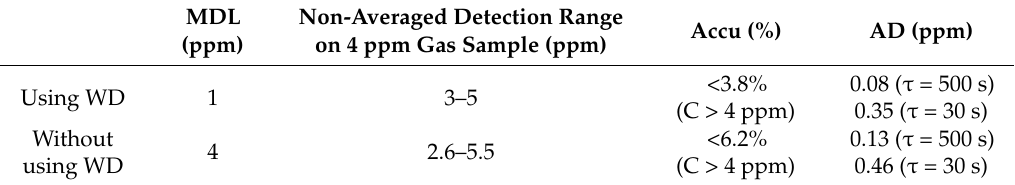
Table 1. Comparison between the sensing performances under the cases of with and without WD use. Accu: accuracy; MDL: minimum detection limit; RT: response time; AD: Allan deviation. This table was obtained from reference [40]. MDL (ppm)